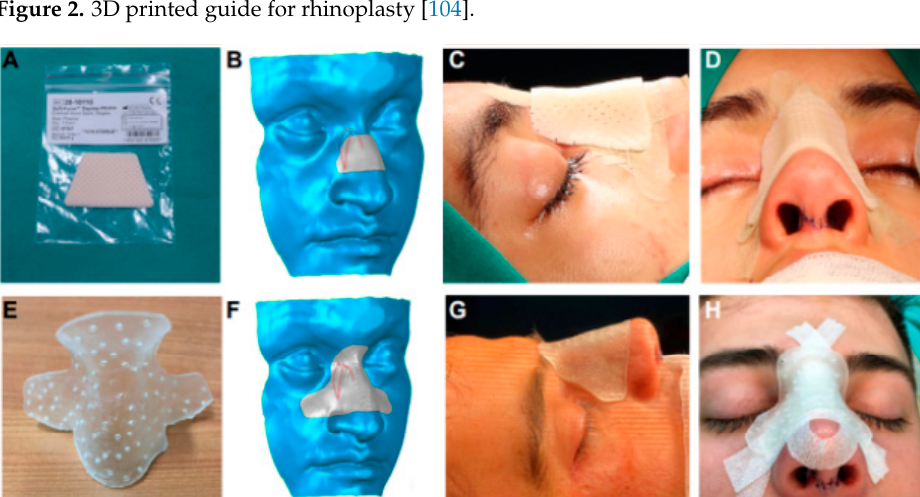
Figure 3. 3D Printed custom ENS and thermoplastic ENS application; A: Thermoplastic external nasal splints; B: Face model of thermoplastic external nasal splints; C: Thermoplastic external nasal splints in lateral view; D: Thermoplastic external nasal splints in frontal view; E: 3D model of external nasal splints; F: 3D model of face model; G: 3D-printed custom external nasal splints in lateral view; H: 3D-printed custom external nasal splints in frontal view 3D [105].